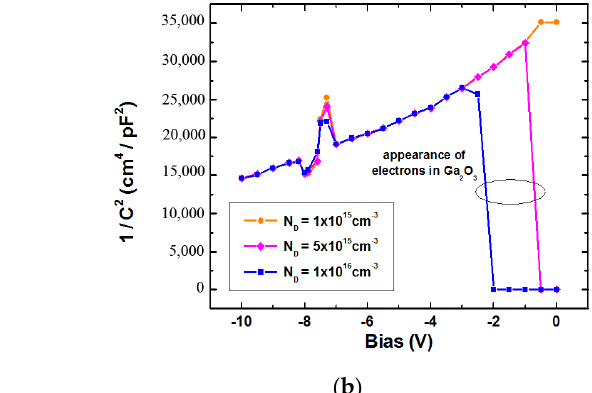
Figure 5. ( a ) Experimental C ‐ V characteristic, ( b ) modeled 1/C 2 versus V for three donor concen ‐ trations.